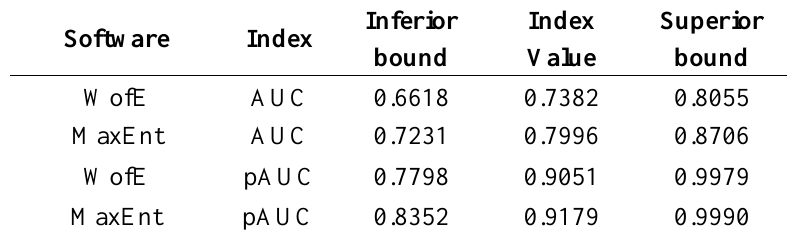
Table 4. AUC and partial AUC values along with their confidence interval using alpha = 0.05 obtained using WofE and MaxEnt. Partial AUC was calculated between 0.95 and one in the True Positive Rate (vertical) axis, values reported are